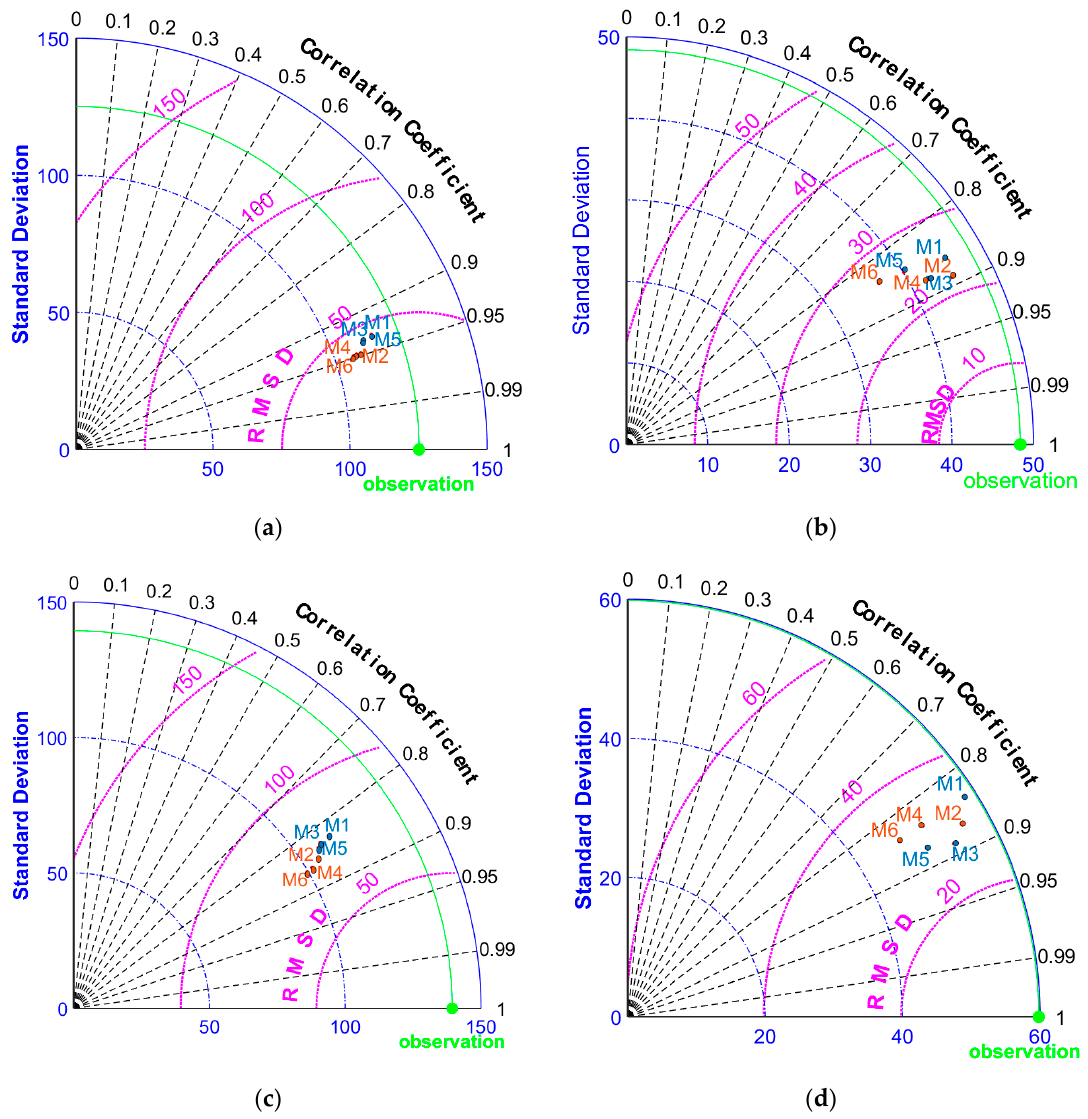
Figure 4. Selected Taylor diagrams [54,55] illustrating significant wave height (H m0 ) model performance as a function of centered-Root-Mean-Square Difference (cRMSD), the correlation coefficient and standard deviation [54]. Units are in centimetres [cm] and are situated at the following locations: ( a ) Cape Town (CT), ( b ) Port Elizabeth (PE), ( c ) FH Platform (FHP), and ( d ) Richards Bay (RB). These results are for JJA 2017. The scenarios (M1 to M6) are prescribed in Table 3.